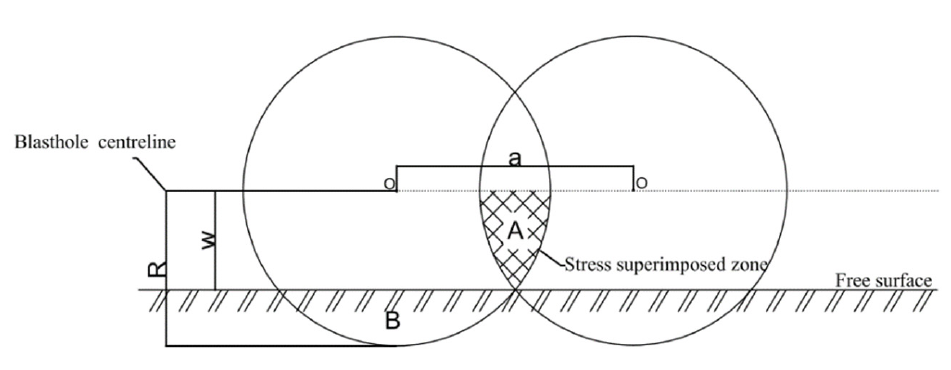
Figure 9. Stress superposition diagram at 0 < W < R, 0 < a < 2R.